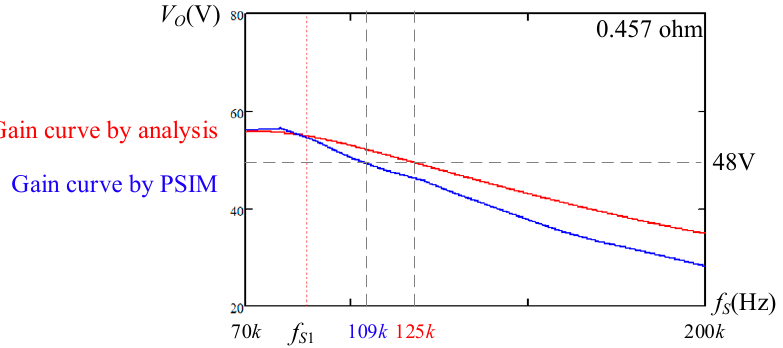
Figure 20. Gain curve comparison at 100% load.